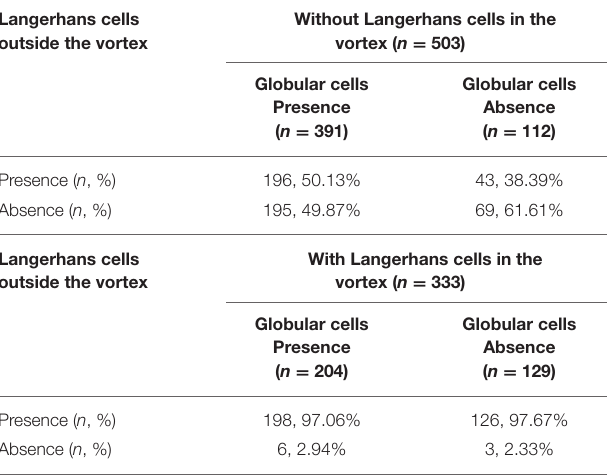
TABLE 3 | Distribution of the Langerhans cells in and outside the corneal nerve